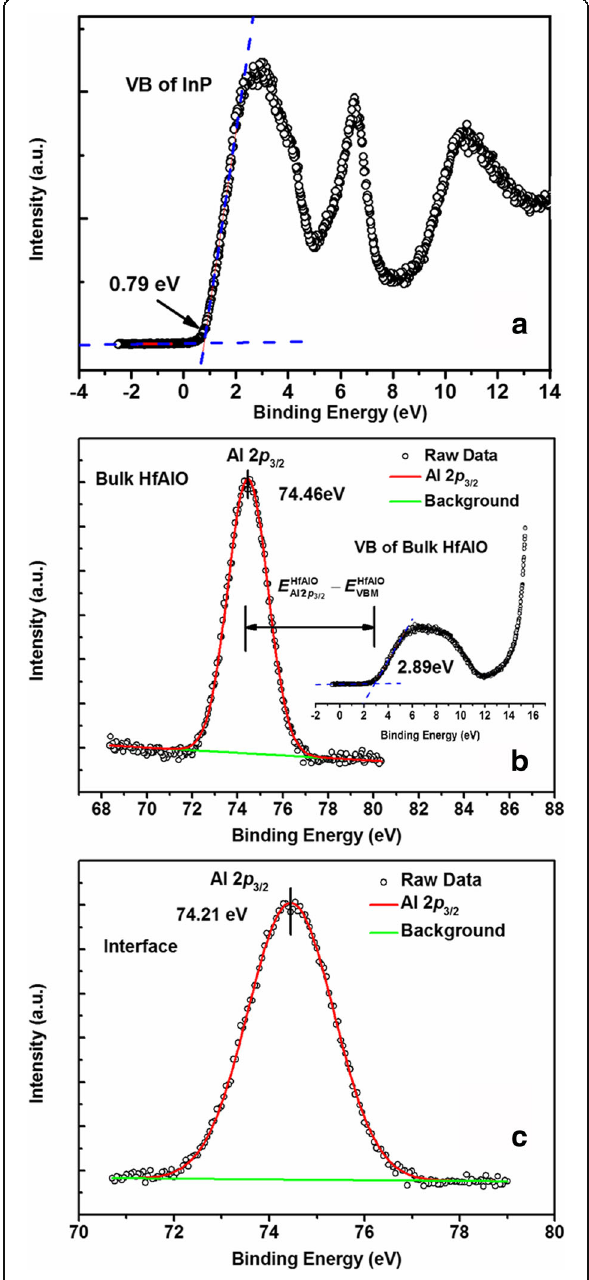
Fig. 5 a Valence band (VB) spectrum of bulk InP. b XPS narrow scan of Al 2 p 3/2 and VB spectrum in bulk HfAlO (30 nm thick). c XPS narrow scan of Al 2 p 3/2 in the HfAlO (4 nm)/InP interface